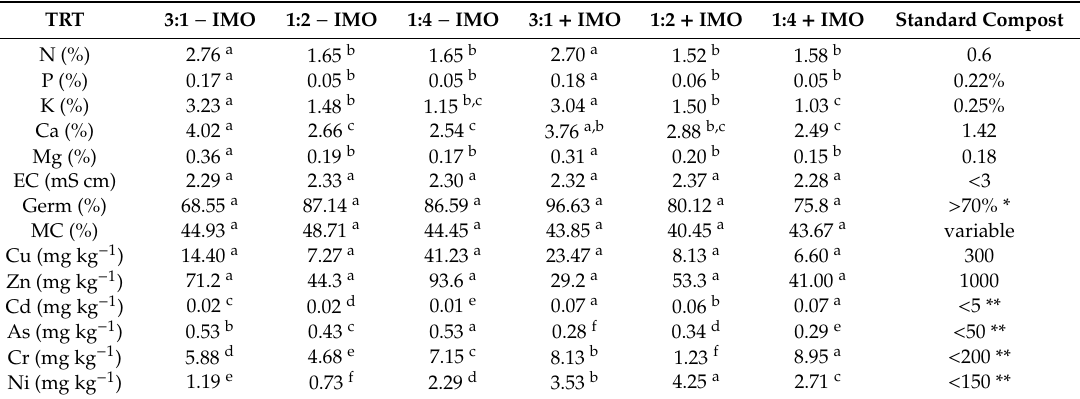
Table 4. Selected final compost quality